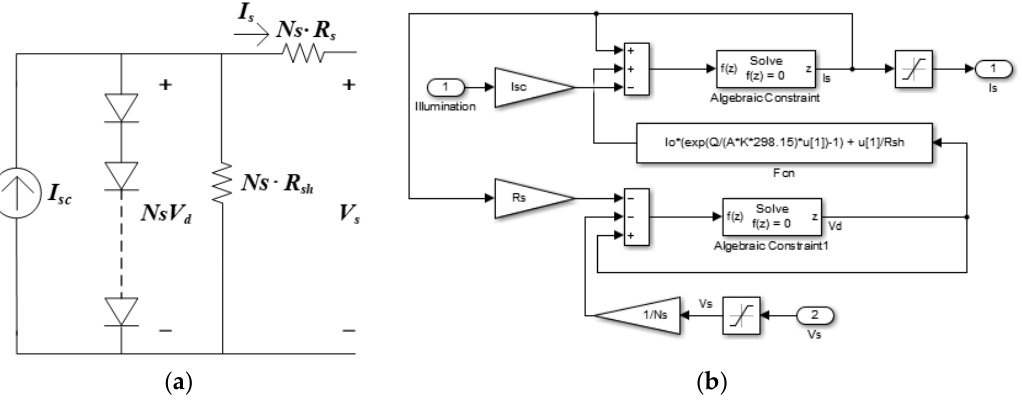
Figure 15. Modeling of laser PV module: ( a ) equivalent circuit model ( b ) simulation model in Matlab.